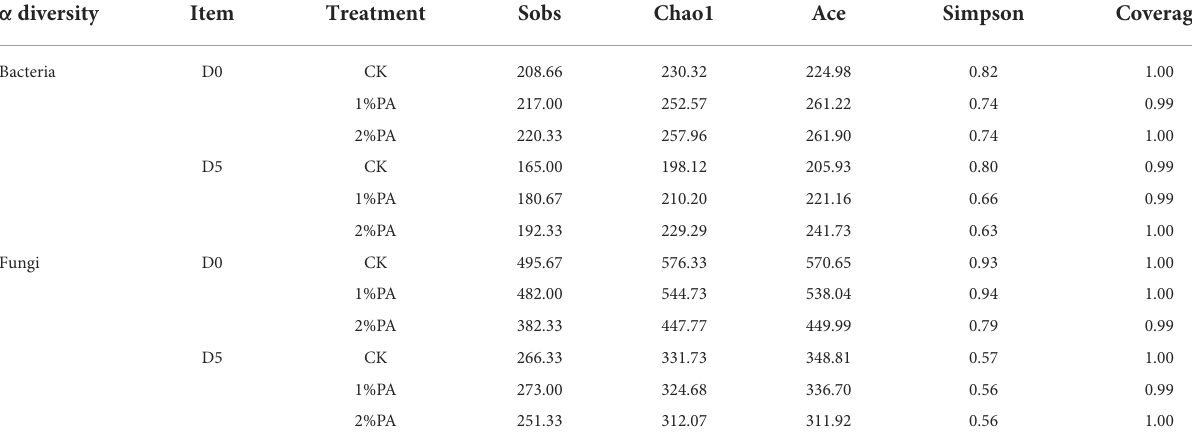
TABLE 3 Alpha diversity of microbial communities of Napier grass silage during aerobic